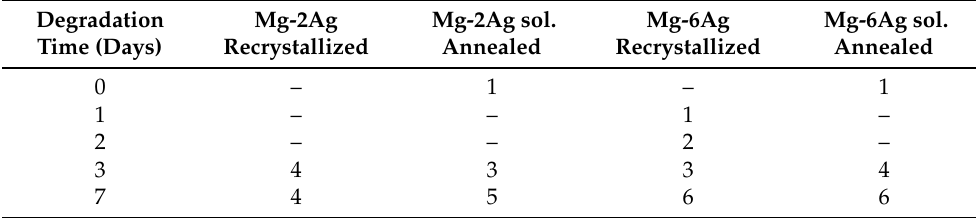
Table 2. Number of obtained tomograms per alloy, treatment, and degradation time.